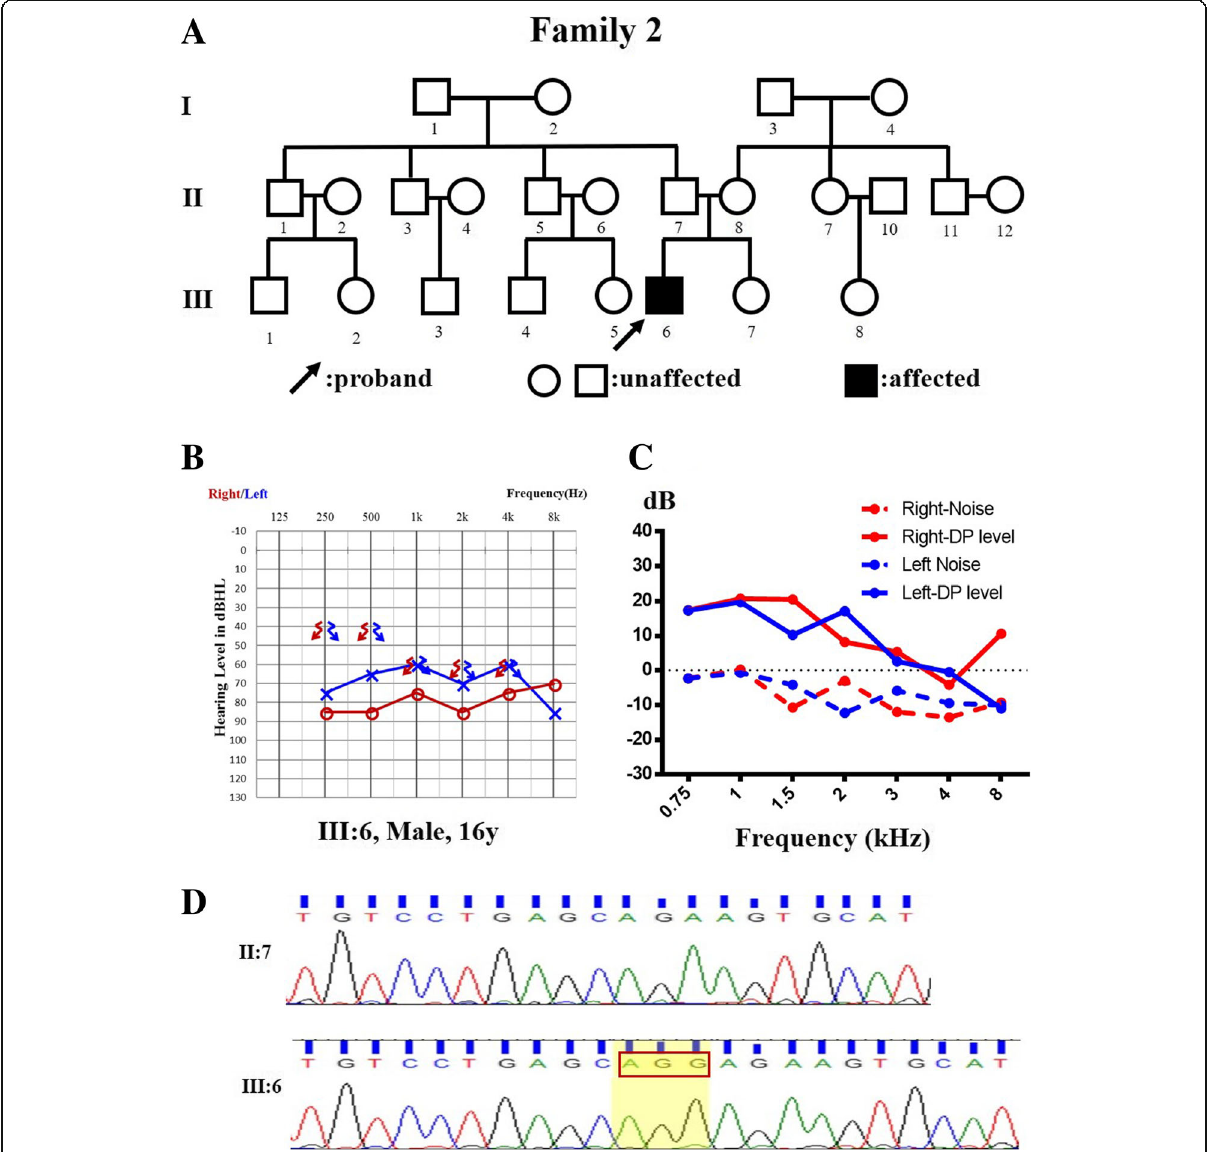
Fig. 2 Pedigree, audiological phenotype and gene variation of Family 2. a Pedigree of Family 2. The affected subject is coloured black, and the proband is indicated by an arrow. b Audiograms of the proband (III:6). c Normal DPOAE result of the proband. d Sequencing chromatograms of TIMM8A showing the deletion in affected individuals (lower panel) compared with normal controls (upper panel). L, left, blue; R, right,